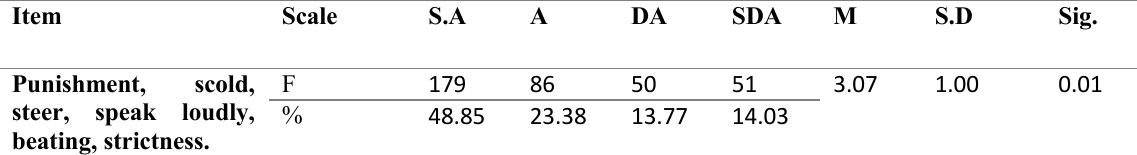
Table 3: Parents opinion about the passive